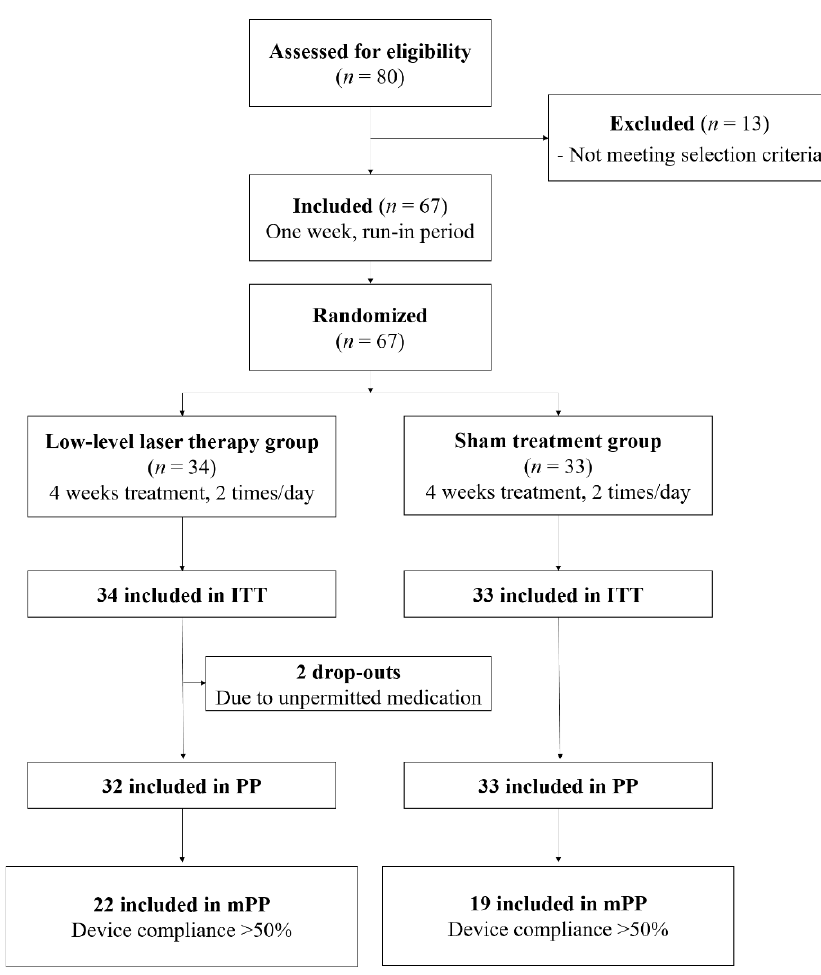
Figure 2. Flow diagram of clinical trial and disposition of patients. Abbreviations: ITT, intent to treat set; PP, per-protocol set; mPP, modified per-protocol set.